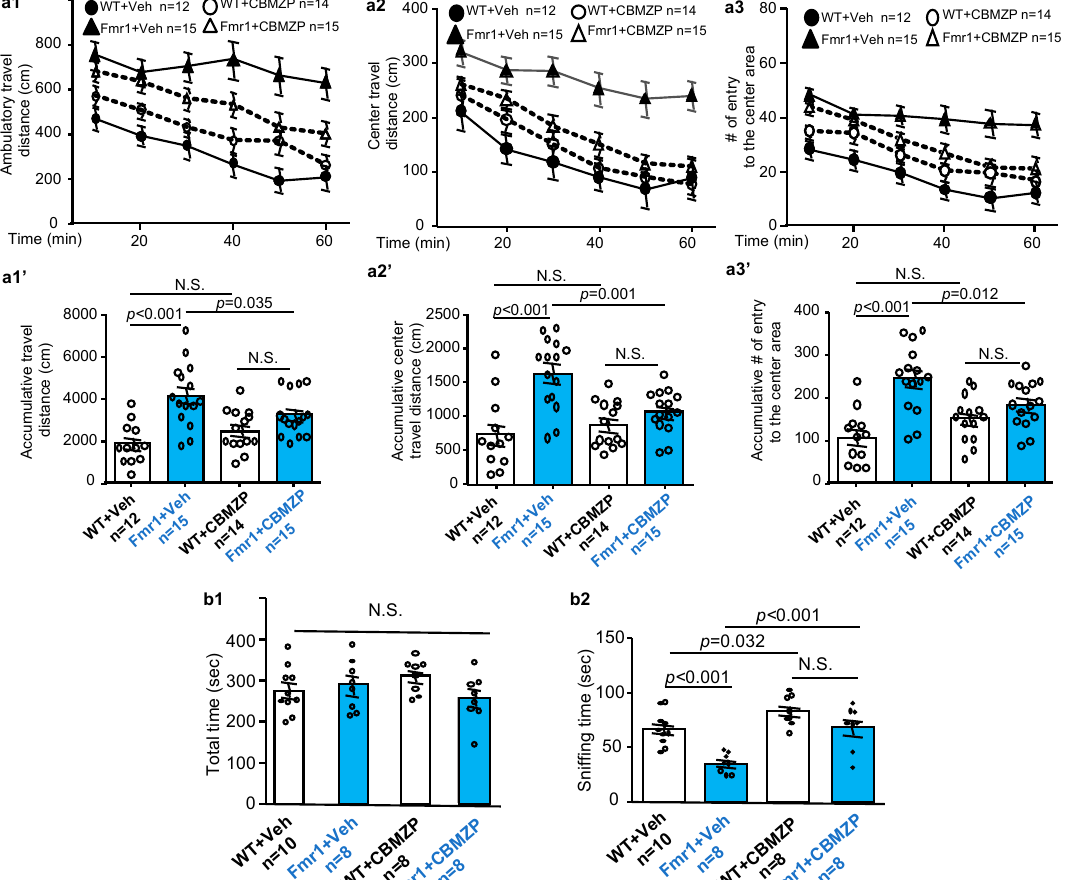
Figure 3. Carbamazepine corrects hyper locomotion and social deficits in FXS mice. 2.5- to 3-month old male wild type (WT) and Fmr1 KO mice received a single ( a1 – a3 ) or repeated (once / day for 8 days) ( b1 , b2 ) injection with vehicle (Veh) (10% DMSO) or 20 mg / kg carbamazepine